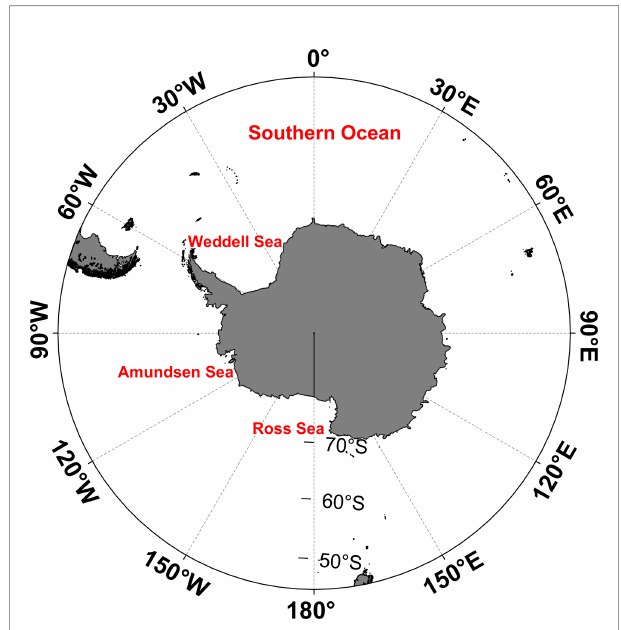
FIGURE 1 | Locations of the Southern Ocean, Weddell Sea, Rose Sea, and Amundsen